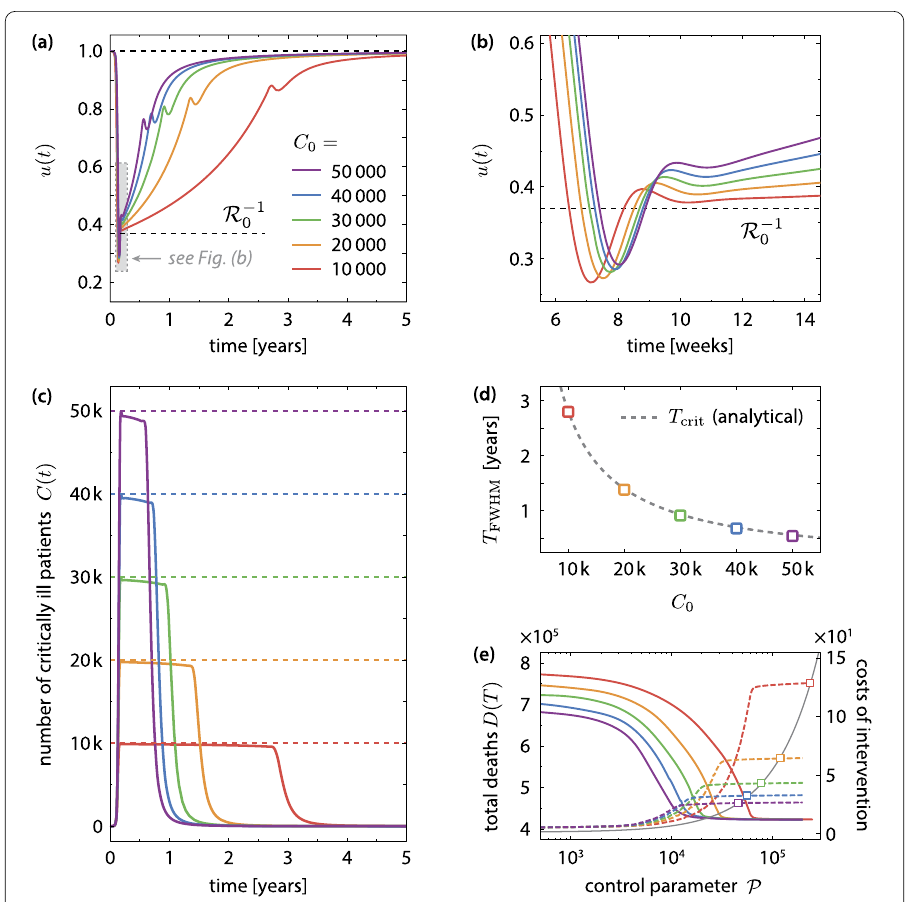
Figure 5 ( a ) Optimal time evolution of the transmission control function u ( t ) for different values of C 0 . The value of C 0 is color-coded. In all scenarios, the interventions start with a strict lockdown, where u ( t ) is reduced below R –1 0 for about 10 to 12 days. This initial lockdown is followed by a long “critical period” during which the measures are gradually relaxed. The length of this period is determined by the peak number of simultaneously critically infected C 0 . Towards the end of the intervention, a moderate tightening of the NPIs is required. ( b ) Same as ( a ), but zoomed on the region with u ( t ) < R –1 0 . ( c ) By optimal transmission control, the number of patients in a critical state C is kept below the limiting value C 0 at all times. ( d ) Characteristic time span T FWHM of the critical period during which the peak number of simultaneously infected must be held constant. The dashed line shows the analytical approximation T crit given in Eq. (17). ( e ) Total number of disease-related deaths (solid lines) and total costs of the measures (dashed lines) at the end of the epidemic vs. the control parameter P (see Sect. 3). The optimized transmission function minimizes the number of disease-related deaths to a C 0 -independent value for P → ∞ , but to a high cost in the case of low C 0 . The squares indicate the minimal values of P that guarantee C ( t ) < C 0 for all